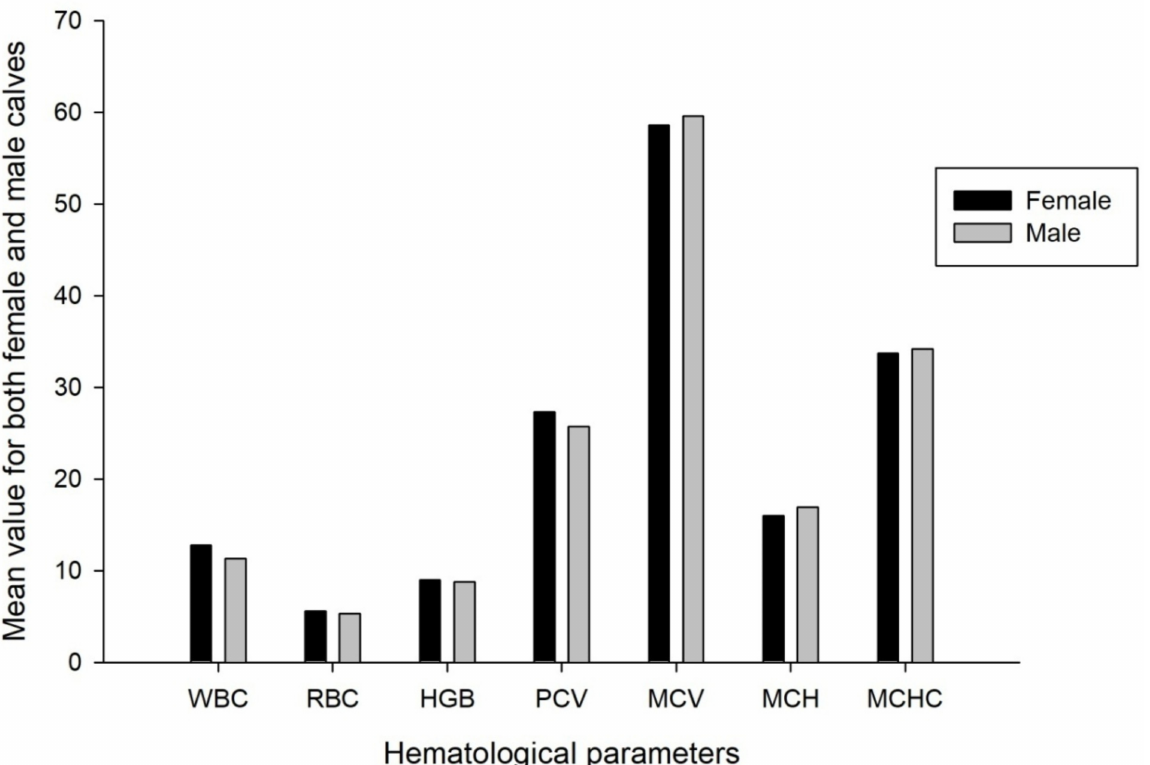
Figure 1. Effect of sex on hematological parameters. WBC ( × 10 µ L − 3 ) = white blood cell in micro liter, RBC ( × 10 µ L − 6 ) = red blood cell in micro liter, HGB (g dL − 1 ) = hemoglobin in gram per deciliter, PCV (%) = packed cell volume in percentage, MCV (fL) = mean corpuscular volume in femtoliter, MCHC (g dL − 1 ) = mean corpuscular hemoglobin in gram per deciliter, MCHC (g dL − 1 ) = mean corpuscular hemoglobin concentration in gram per deciliter.